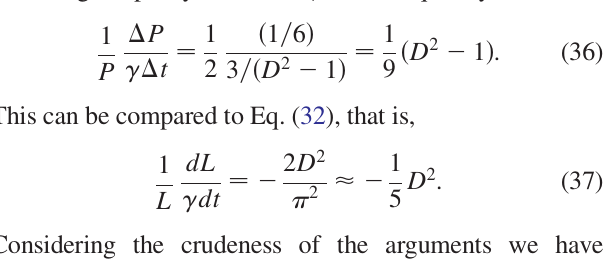
Figs. 12(a) and 12(d) look like the states in the QFT basis (Pegg-Barnett phase states). The Wigner functions plotted in Figs. 12(b) and 12(c) are, however, quite different—they contain a hole which is more negative than the dips in Figs. 12(a) and 12(d). The states plotted in Figs. 12(b) and 12(c) can be said to be highly nonclassical because of